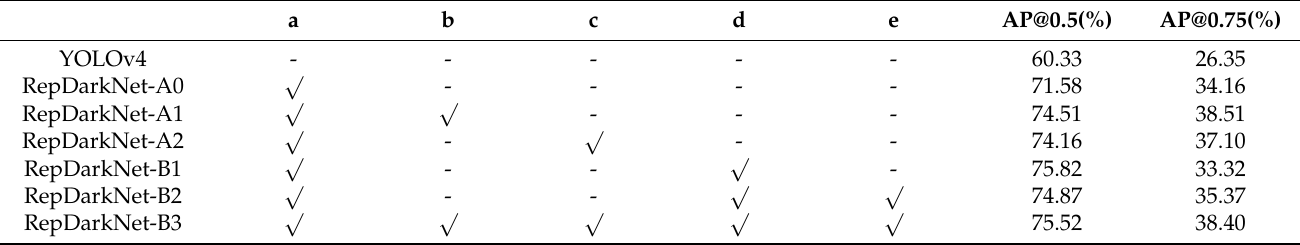
Table 1. Improvement options and comparison of